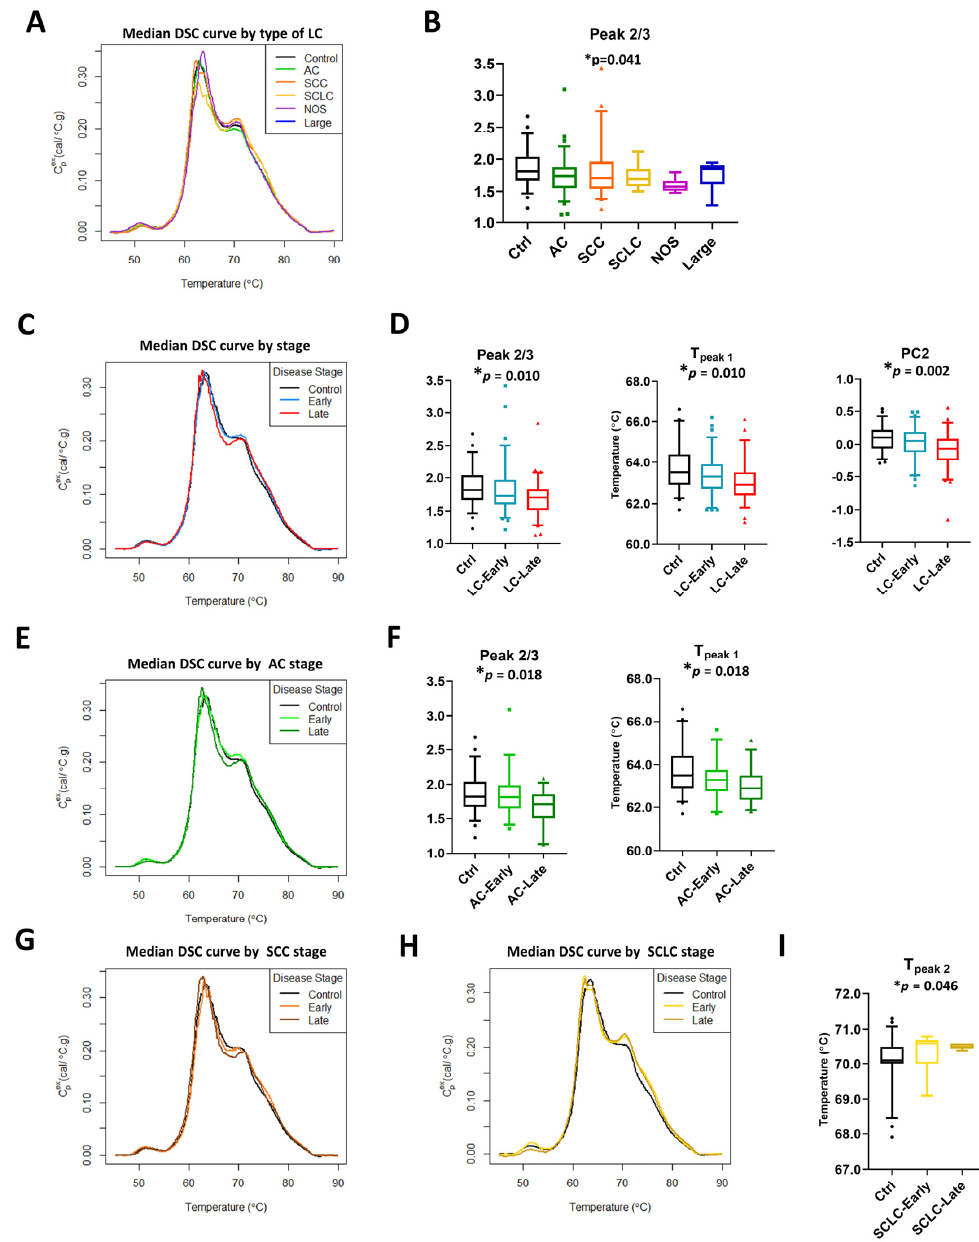
Figure 3. Subtypes and stage-related differences in DSC curves of LC specimens. ( A ) Plot of the median DSC curve value at each temperature for different subtypes of LC and control subjects. ( B ) Boxplots of selected summary metrics calculated from DSC curves for controls and different subtypes of LC patients. Plot of the median DSC curve value at each temperature for control subjects and early stage (stage 1–3a) or late stage (stage 3b–4) LC ( C ), AC ( E ), SCC ( G ), and SCLC ( H ) patients. Boxplots of selected summary metrics and PCs calculated from DSC curves for controls and early/late stage LC ( D ), AC ( F ), and SCLC ( I ) patients. *, adjusted p -value < 0.05